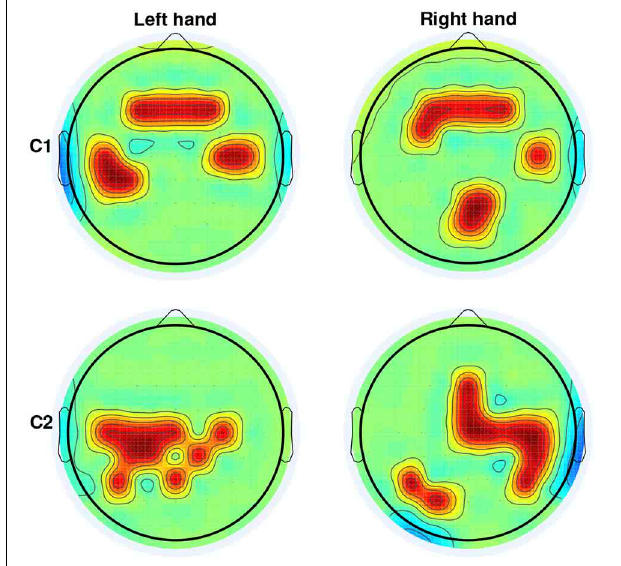
FIGURE 3 | Selection of channels (in red) from CVA yielding the highest DA for able-bodied subjects C1 and C2 for left and right arm reaching movements. For both subjects and arms, channels were selected on the window ending at 62.5ms before movement onset.